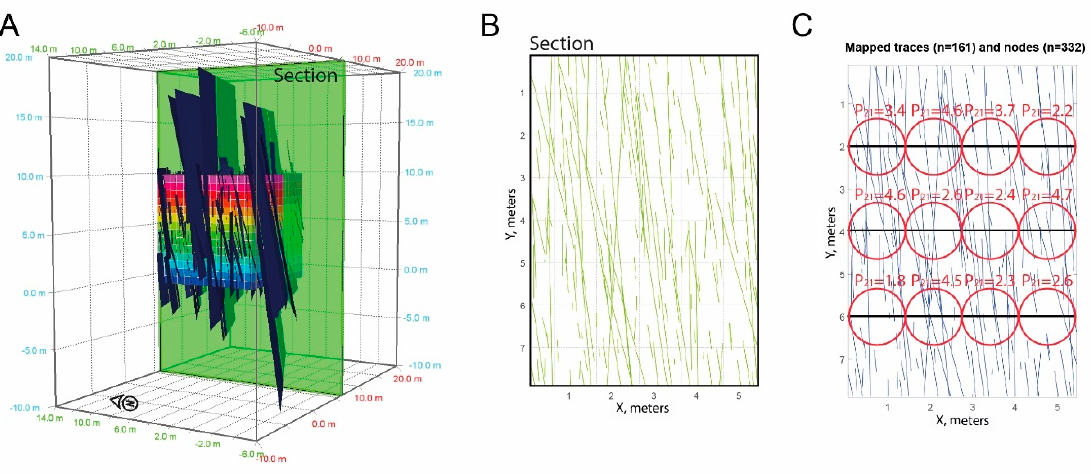
Figure 5. ( A ) Initial discrete fracture network (DFN) model. ( B ) Extraction of the 2D cross section. ( C ) Calculation of P 21 in the section extracted from 3D DFN.